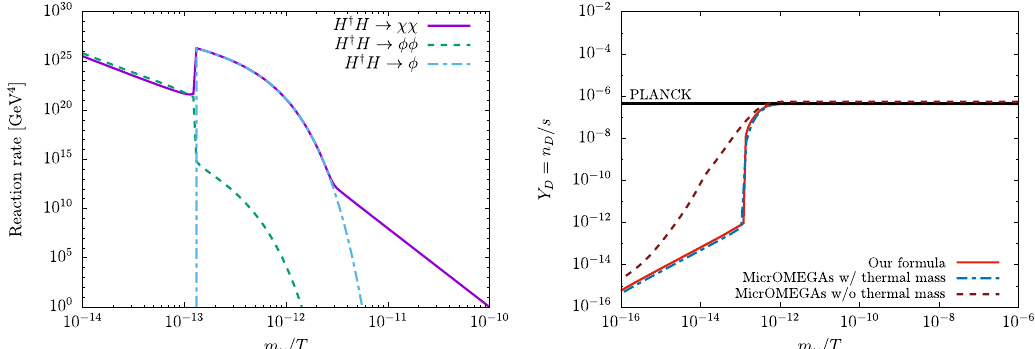
Figure 1 . Left: evolution of the reaction rates for three processes eqs. (3.10)–(3.12). Right: evolution of the dark matter yield determined by solving the Boltzmann equation. The red solid, dot-dashed dark blue and dashed brown lines denote the results using our formula (3.9), the public code MicrOMEGAs with and without the thermal mass effect for the SM Higgs boson, respectively. The black horizontal line corresponds to the correct dark matter abundance for m